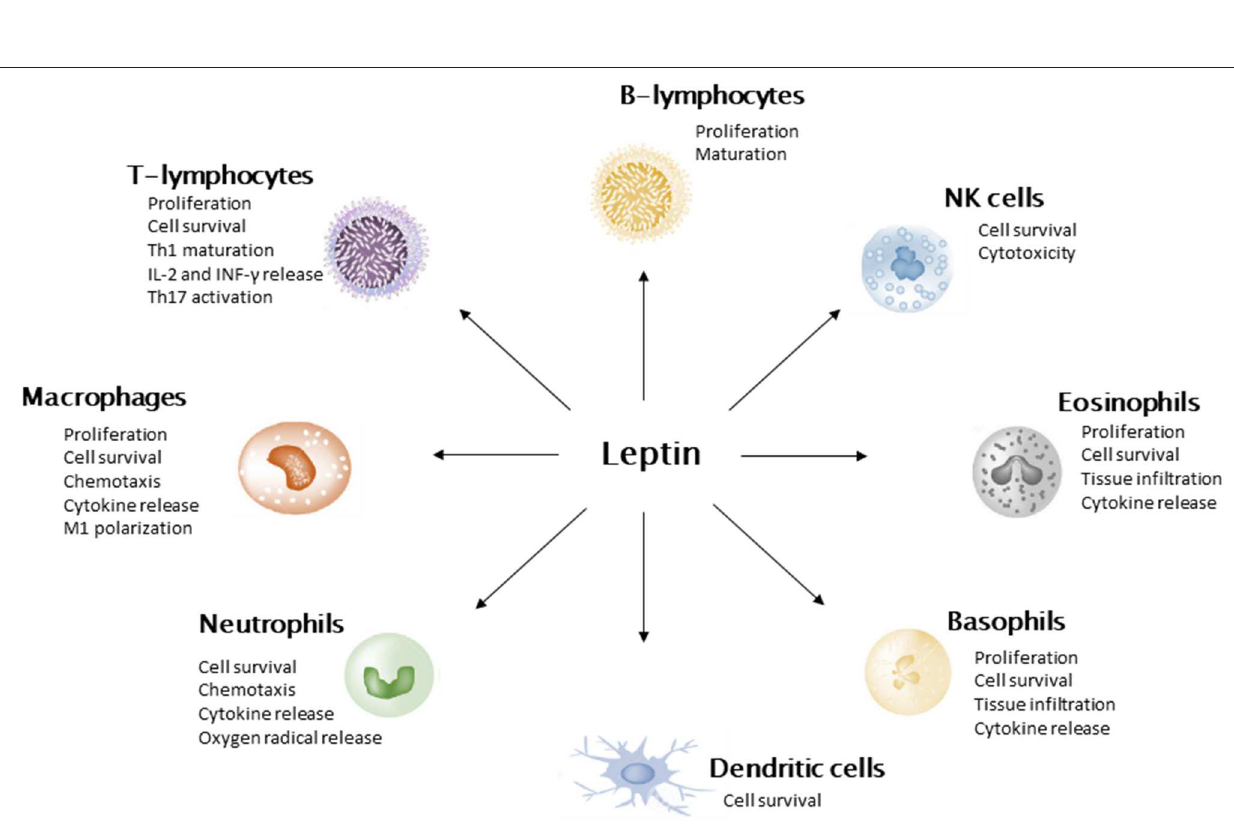
Frontiers in Pediatrics | www.frontiersin.org